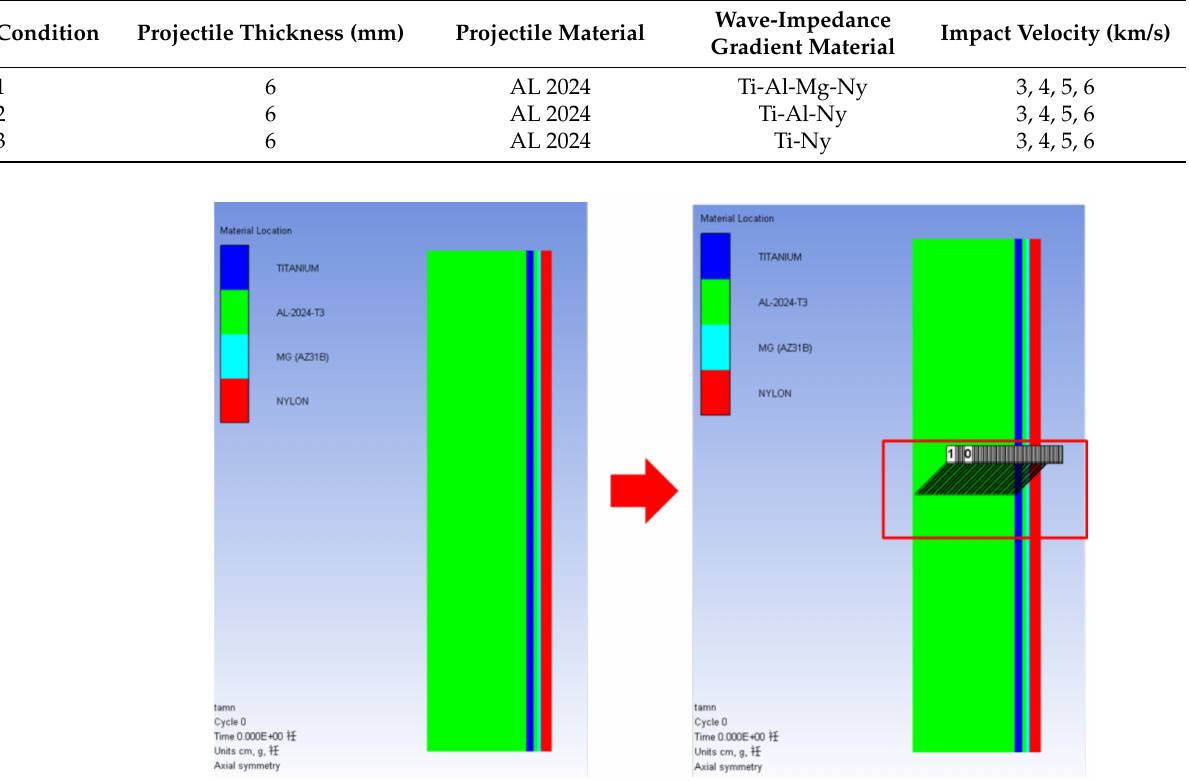
Table 6. Calculation-model parameters.